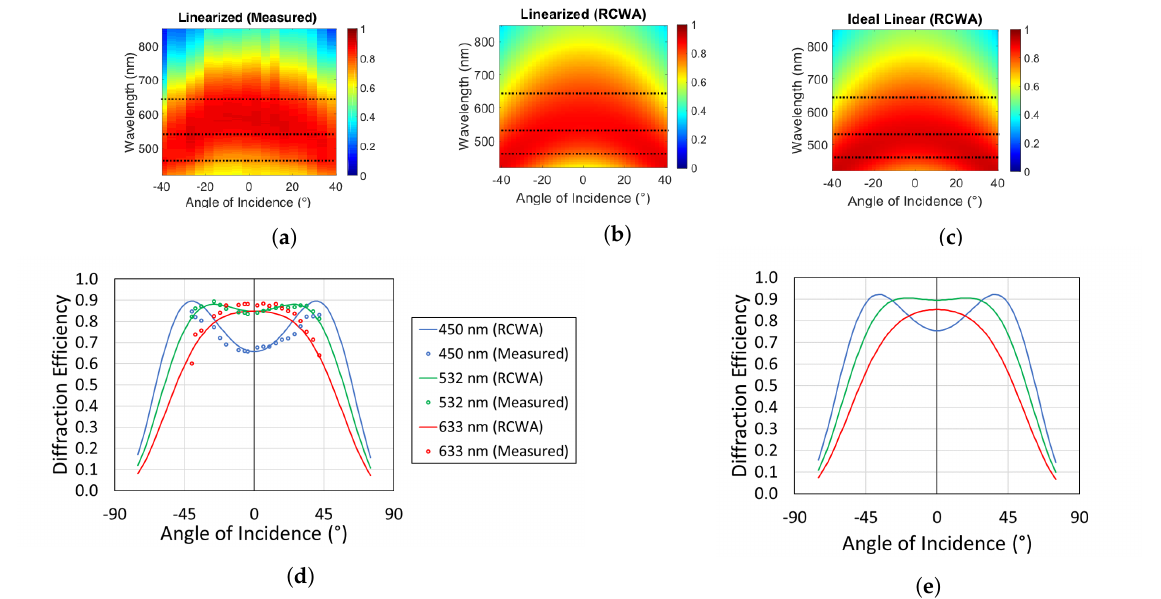
Figure 6. ( a ) Measured diffraction efficiencies for a 16-state, linearized blazed grating, ( b ) RCWA-simulated, and ( c ) ideal linear phase distribution. Dashed lines correspond to common laser lines at 450 nm, 532 nm, and 632.8 nm shown in ( d ) for linearized PLM phase levels and ( e ) an ideal linear 16-level grating.